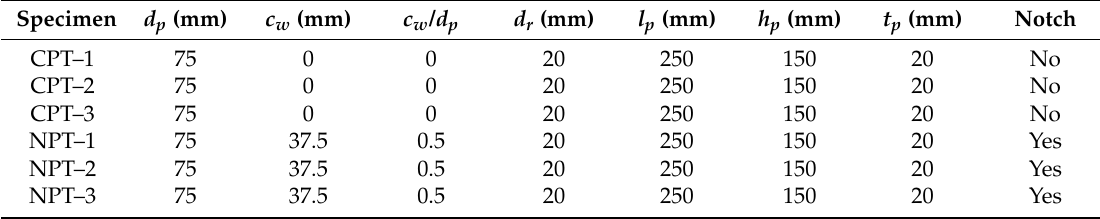
Table 1. Pull-out test specimens. Table 1. Pull - out test specimens. Table 1. Pull - out test specimens.